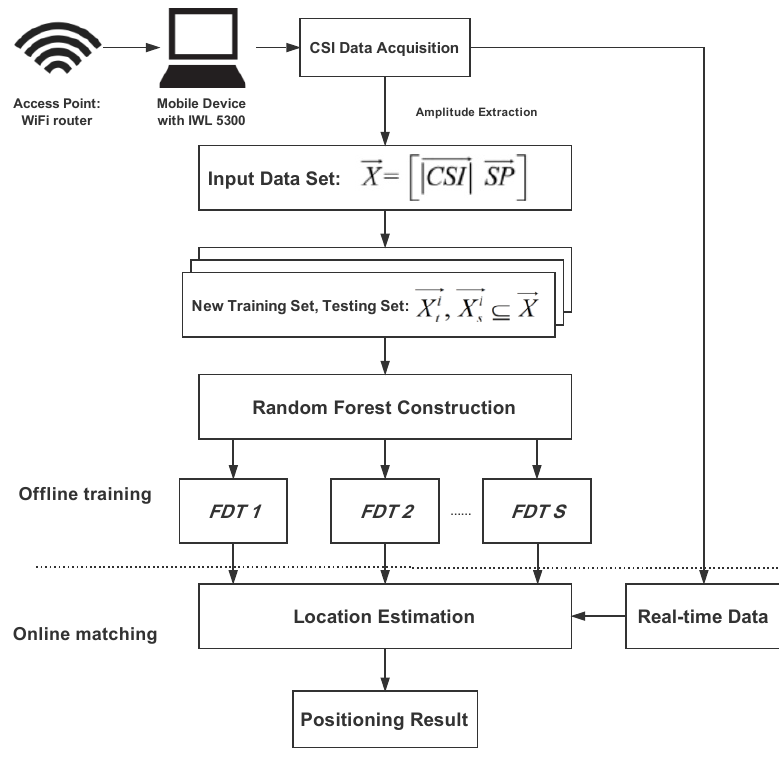
Figure 6. Random Forest fingerprinting localization (RFFP) system